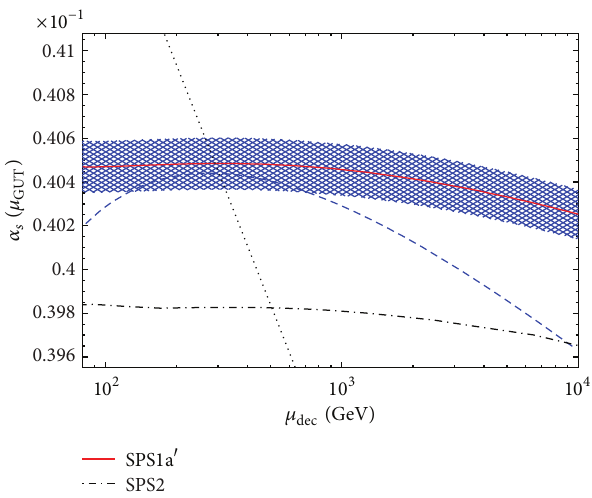
) as a function of 𝜇 Figure 6: 𝛼 𝑠 (𝜇 from [50]. Dotted, dashed, GUT dec and solid lines denote the one-, two-, and three-loop contributions, respectively, obtained using for the input parameters their values for the SPS1 𝑎 󸀠 benchmark point. The dash-dotted line shows the three- loop running corresponding to the SPS2